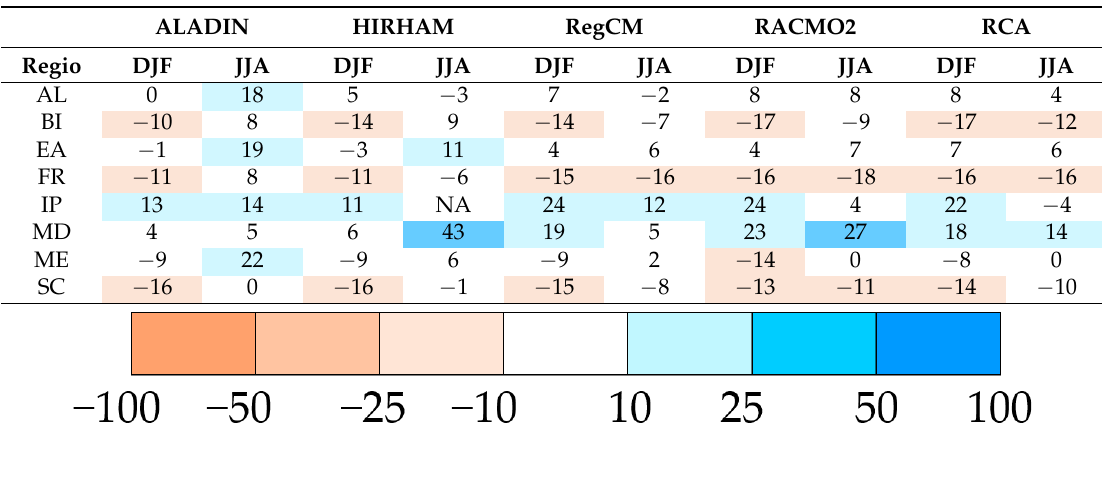
Table 10. Residual bias of the seasonal amount of simulated precipitation (a) in the case of local intensity scaling of the precipitation bias correction method in the test period in eight different regions: the Alps (AL), the British Isles (BI), Eastern Europe (EA), France (FR), the Iberia Peninsula (IP), the Mediterranean (MD), Mid-Europe (ME) and Scandinavia (SC) in DJF and JJA. The bias values are in %. The extremely large bias in the case of HIRHAM RCM in IP in the in JJA season is denoted by NA where the bias value is about 3 × 10 12